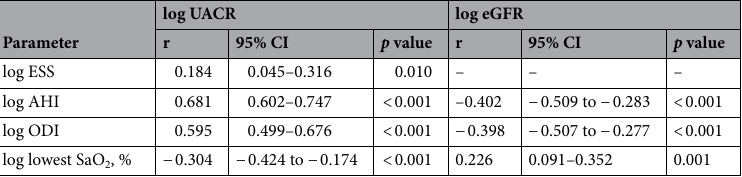
Table 3. Relationship between sleep characteristics and renal function parameters in patients with diabetic kidney disease. Variables are log transformed and data recorded are Spearman’s correlation coefficient, 95% confidence interval of the correlation and p value. UACR urinary albumin–creatinine ratio, eGFR estimated glomerular filtration rate, ESS Epworth sleepiness scale, AHI apnea–hypopnea index, ODI desaturation index, SaO 2 oxygen